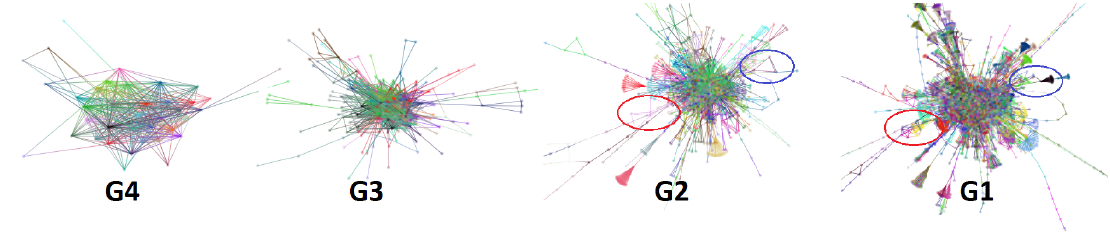
Figure 10. Four level coarsen graph layout of web-Stanford data (graph nodes colored by cluster membership). From coarse to fine, the graph levels are G 4 , G 3 , G 2 , G 1 . The red and blue circles are highlighted